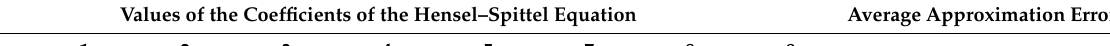
Table 2. Hensel–Spittel equation data.